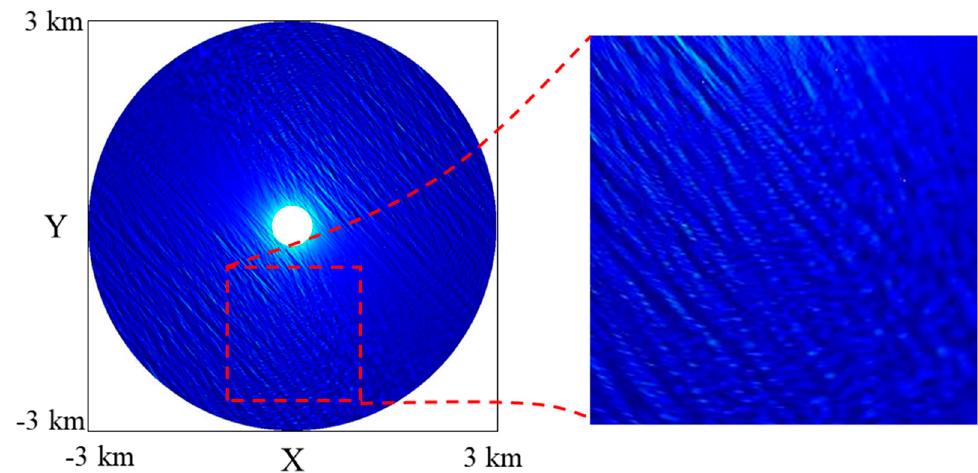
Figure 3. A numerical simulated radar image (the left part) and the cropped portion (right).